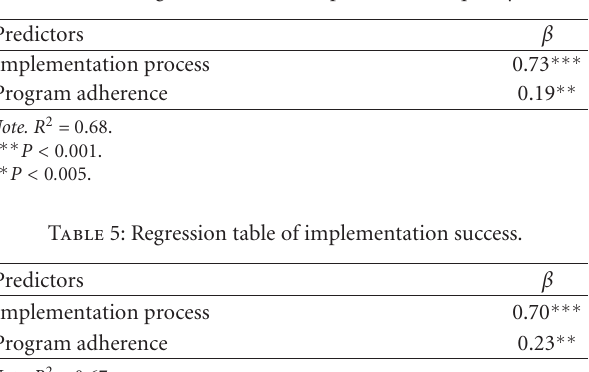
Table 4: Regression table of implementation quality.